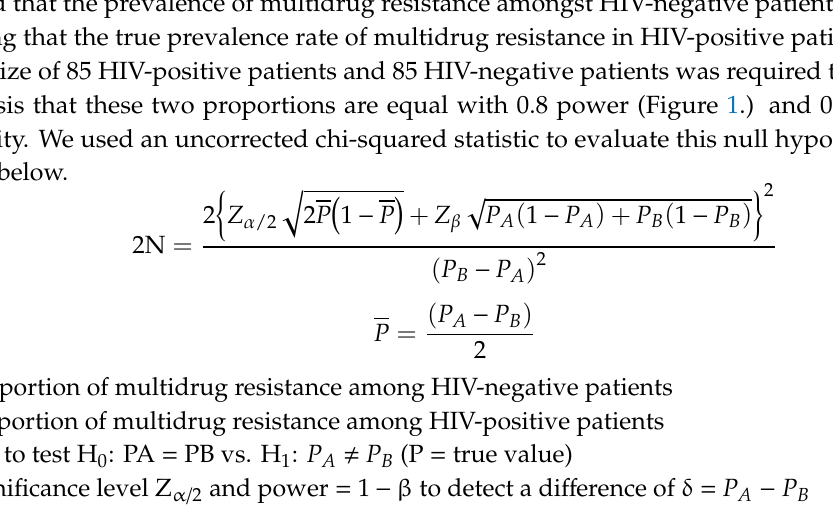
P A = proportion of multidrug resistance among HIV-negative patients P B = proportion of multidrug resistance among HIV-positive